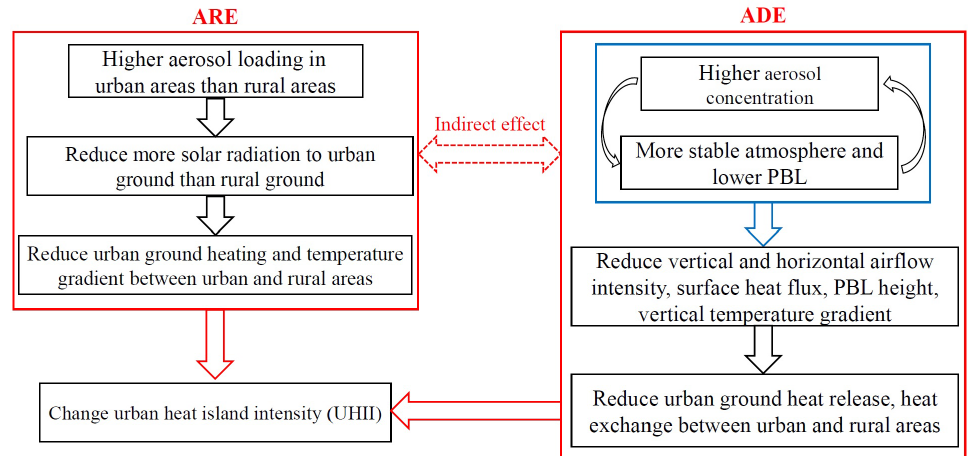
Figure 5. Diagram of the mechanisms behind aerosol effects on the UHII. The blue frame contains the processes and interactions between aerosols and the PBL. Red frames contain the processes of the aerosol radiative effect (ARE) and the aerosol dynamic effect (ADE). Solid arrows denote direct effects, while the dashed arrow indicates the indirect